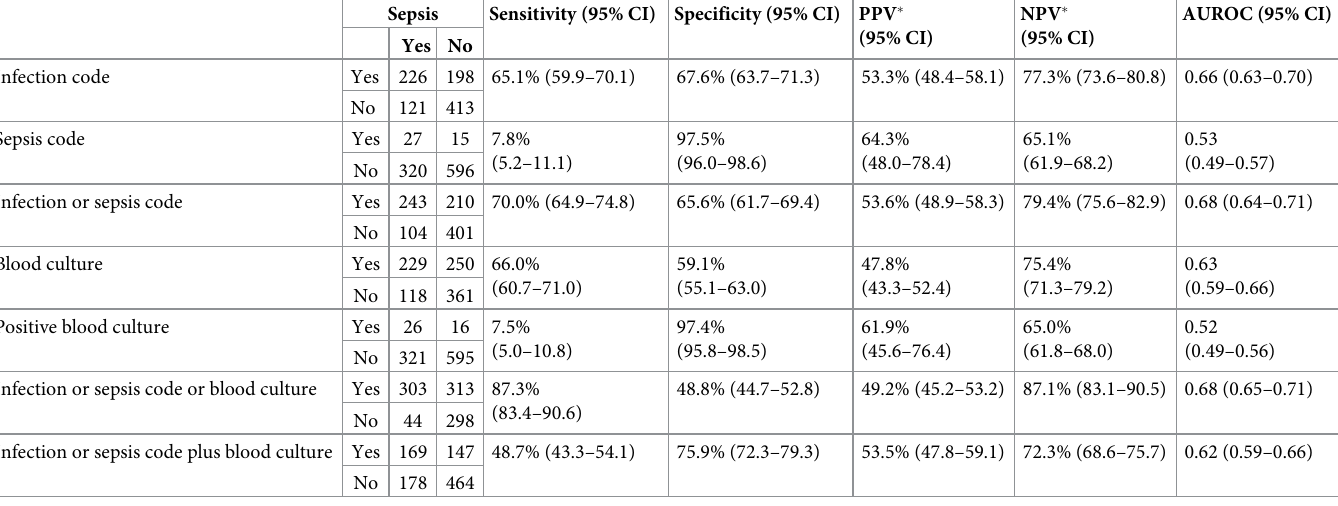
Table 4. Performance characteristics of administrative data to identify people with